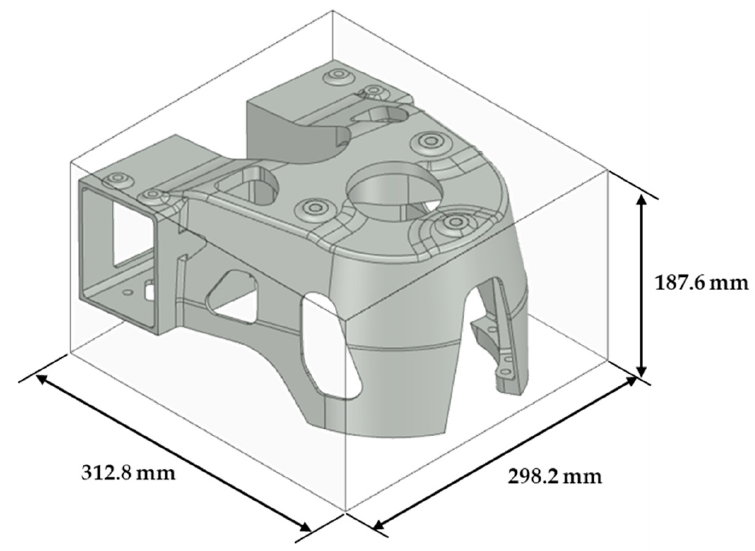
Figure 5. Optimally designed shock absorber node part. Table 1. Laser powder bed fusion process parameters.